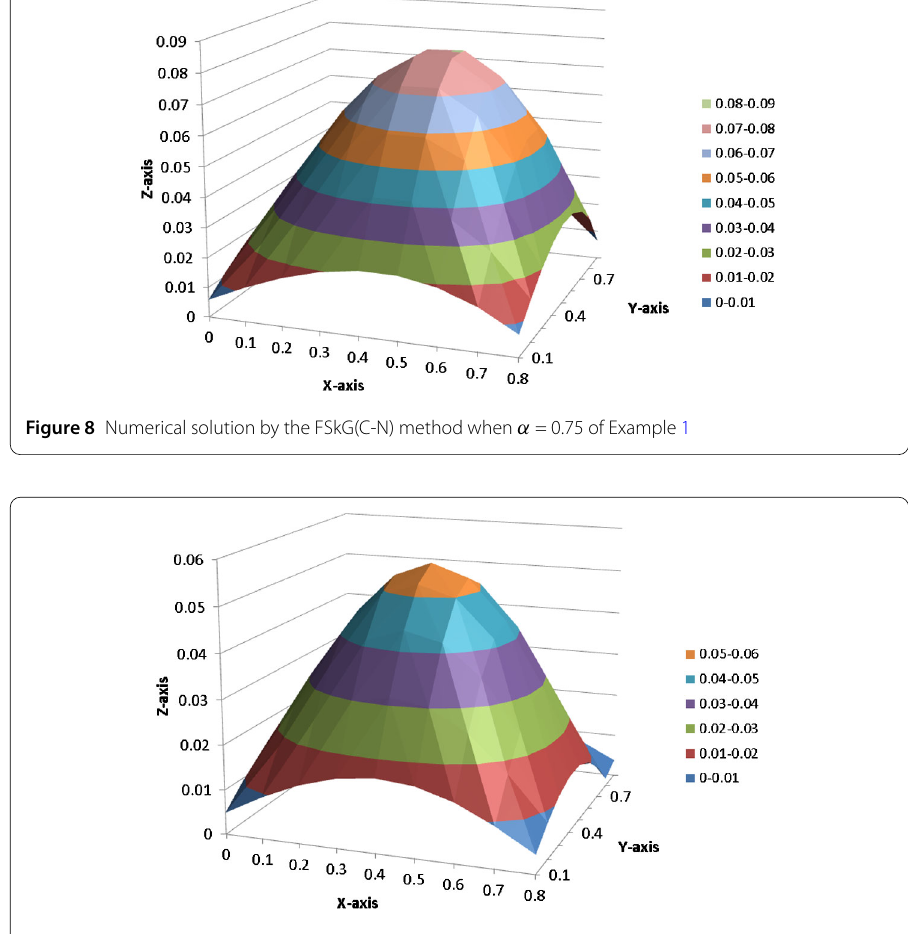
Figure 9 Numerical solution by the FSkG(C-N) method when α = 0.85 of Example